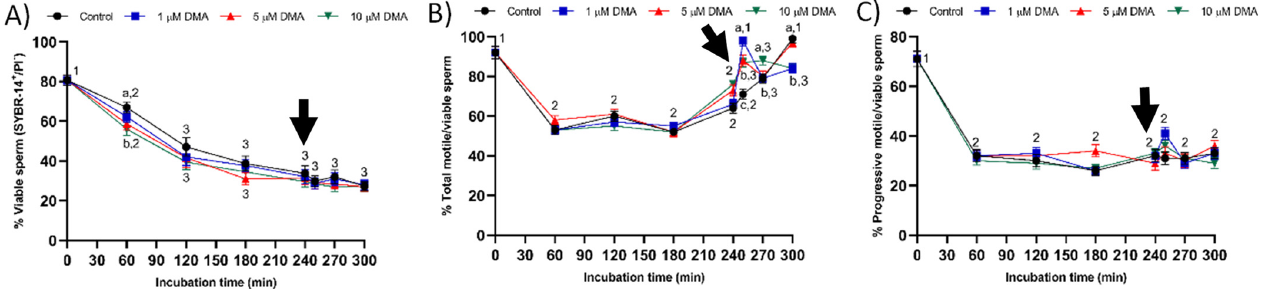
Figure 3. Percentages of viable sperm ( A ), total motile/viable sperm ( B ), and progressively motile/viable sperm ( C ) during in vitro capacitation in the control and samples blocked with 1, 5, and 10 µM DMA. Different letter superscripts indicate significant differences between control and blocked samples in sperm viability and total motility within a single time point ( p < 0.05); lack of letter superscripts indicate no significant differences in progressive motility between treatments within a single time point ( p > 0.05). Different numeral superscripts indicate significant differences between two consecutive time points within a treatment ( p < 0.05). Since the pattern of variation of sperm viability and progressive motility throughout the incubation time was similar between control and blocked samples, all treatments have the same numeral superscript assigned to each time point. The arrow indicates the addition of 10 µg/mL of progesterone at 240 min of incubation. Results are expressed as the mean ± SEM ( n = 9).